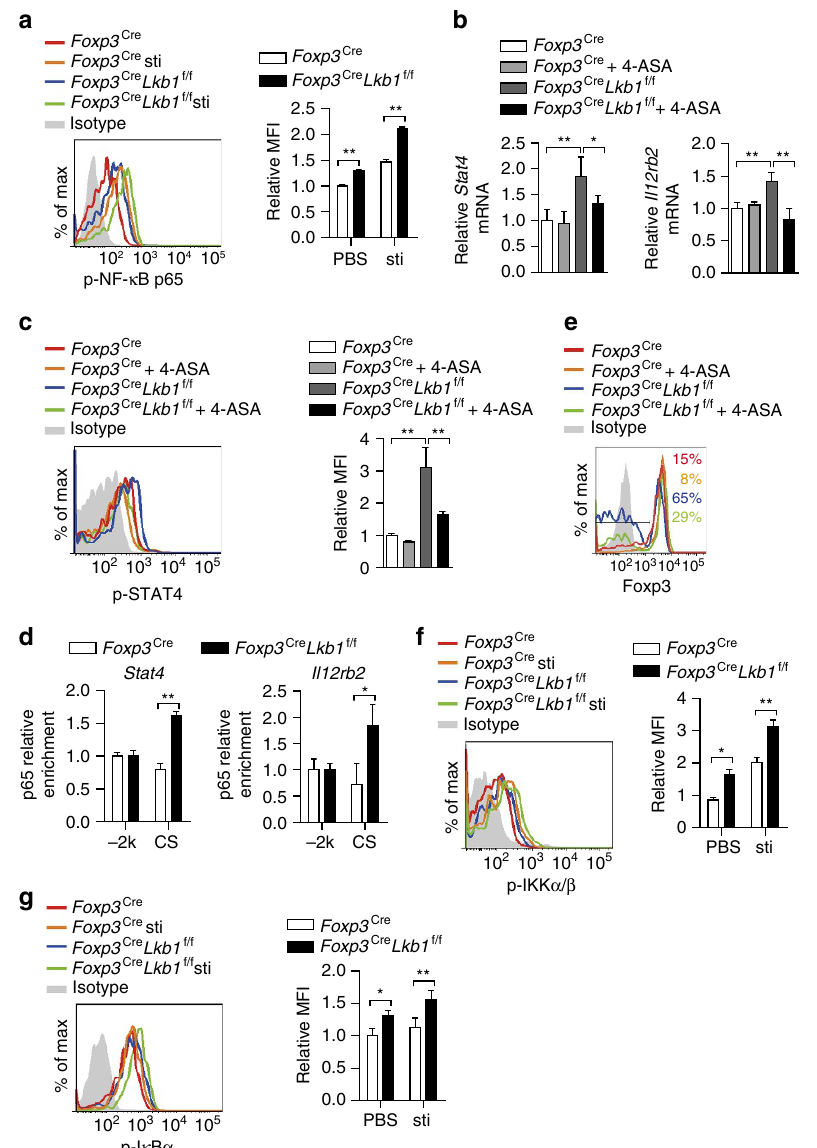
Figure 6 | Lkb1 suppresses NF- j B signalling to restrain STAT4 activation. ( a ) Intracellular phosphorylated NF- k B p65 in Foxp3 Cre and Foxp3 Cre Lkb1 f/f T reg cells with or without IL-2 stimulation ( n ¼ 3). ( b ) Stat4 and Il12rb2 mRNA in Foxp3 Cre and Foxp3 Cre Lkb1 f/f T reg cells supplemented with or without 4-ASA for 16h ( n ¼ 3). ( c ) Intracellular phosphorylated STAT4 in Foxp3 Cre and Foxp3 Cre Lkb1 f/f T reg cells supplemented with or without 4-ASA ( n ¼ 3). ( d ) P65 enrichment to consensus sequences (CS) in Stat4 and Il12rb2 locus in Foxp3 Cre and Foxp3 Cre Lkb1 f/f T reg cells determined by ChIP. ( e ) Foxp3 expression in Foxp3 Cre and Foxp3 Cre Lkb1 f/f T reg cells co-cultured with DCs supplemented with IL-2 and IL-12, with or without 4-ASA. ( f ) Intracellular phosphorylated IKK a (Ser176/180)/ b (Ser177/181) in Foxp3 Cre and Foxp3 Cre Lkb1 f/f T reg cells with or without IL-2 stimulation ( n ¼ 3). ( g ) Intracellular phosphorylated I k B a (Ser 32/36) in Foxp3 Cre and Foxp3 Cre Lkb1 f/f T reg cells with or without IL-2 stimulation ( n ¼ 3). Two-way analysis of variance (ANOVA) was used for statistical analyses in ( a , b , c , d , f , g ) (* P o 0.05, ** P o 0.01); error bars represent s.d.; all data are representative of at least two independent experiments.